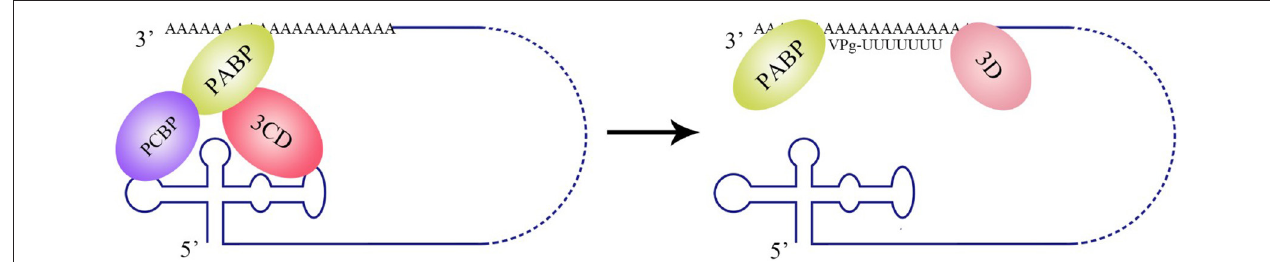
FIGURE 5 | Circularization of the PV genome and initiation of negative-strand RNA synthesis. PV polypeptide and cellular factor poly(C)-binding protein (PCBP) bind to the 5 ′ UTR cloverleaf, and cellular factor poly(A)-binding protein (PABP) binds to the 3 ′ UTR. 3CD, PCBP, and PABP interact with each other and lead to the cyclization of the genomic RNA, which brings the viral RdRP (3D protein) in close proximity to the 3 ′ poly(A) tail and facilitates the initiation of negative-strand RNA synthesis (Herold and Andino,